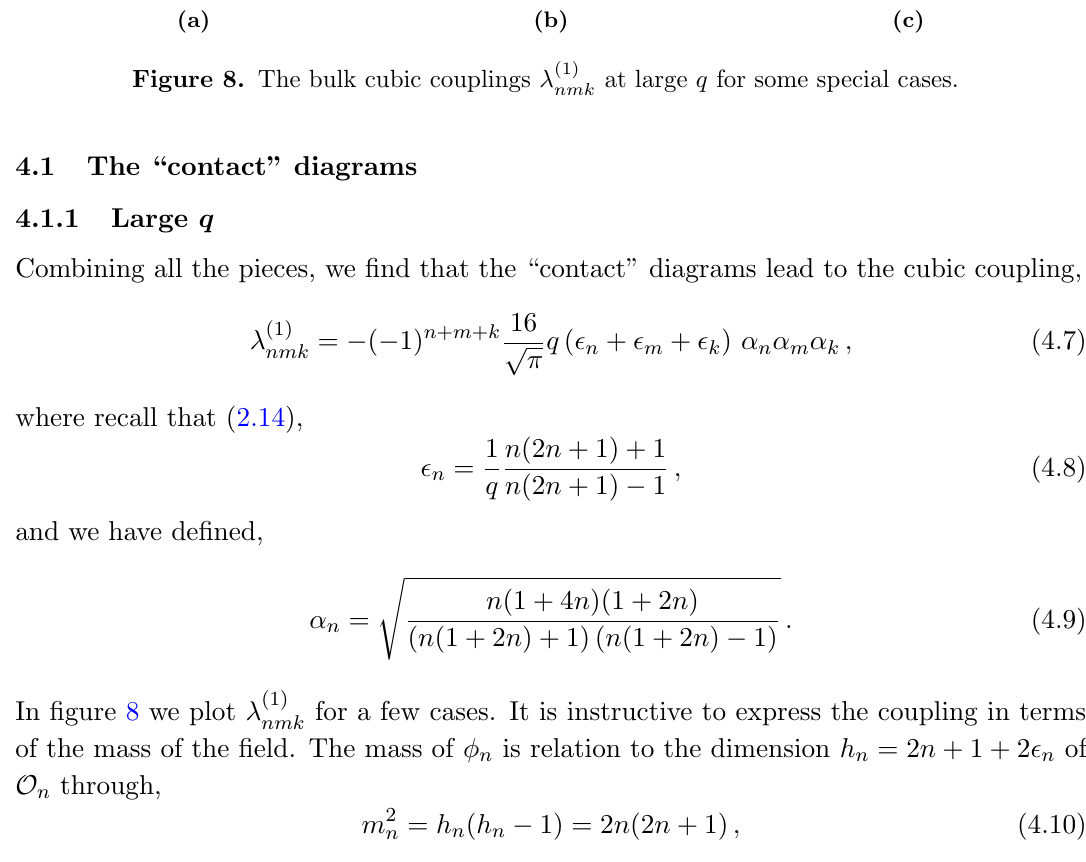
Figure 8. The bulk cubic couplings (cid:21) (1)